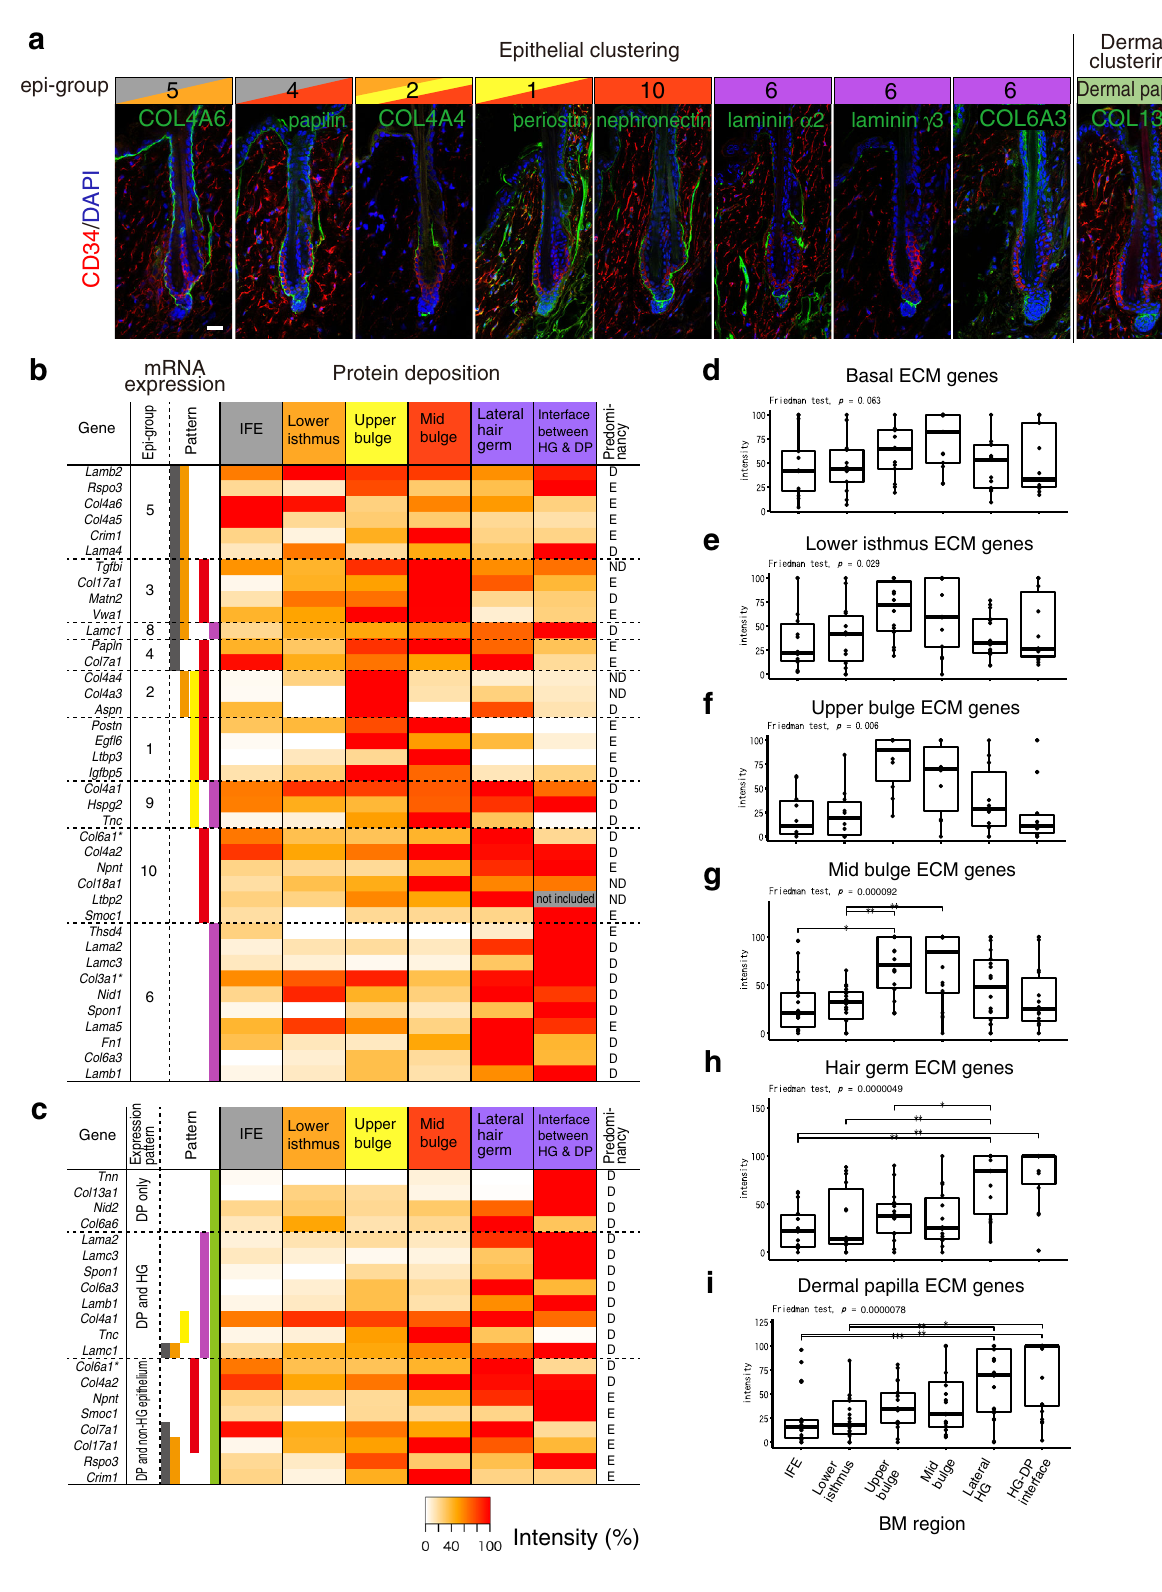
expression pro fi les of their own and neighbouring cells. This lays the foundation for predicting ECM niches of single cells within tissues using large-scale single-cell gene expression data sets, such as the Human Cell Atlas 47 and the mouse atlas Tabula Muris 48